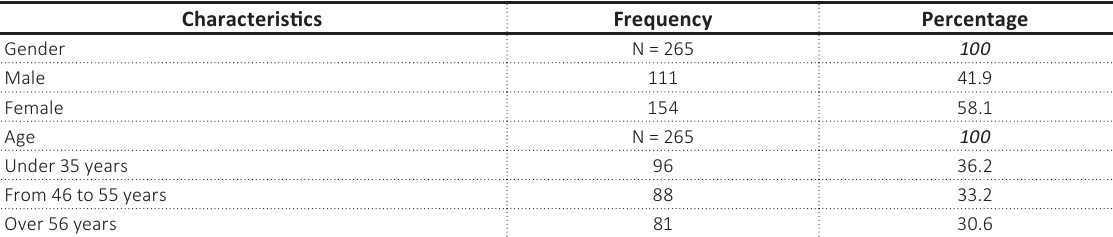
Table 1. General information of the research data